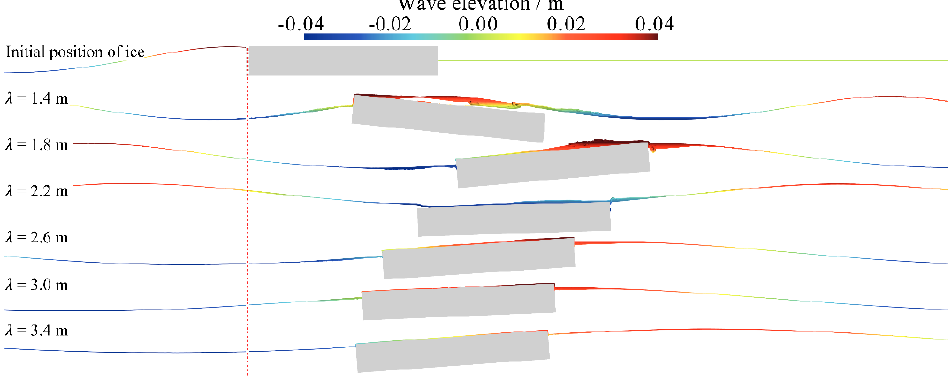
Figure 15. Floating ice attitude at T = 20